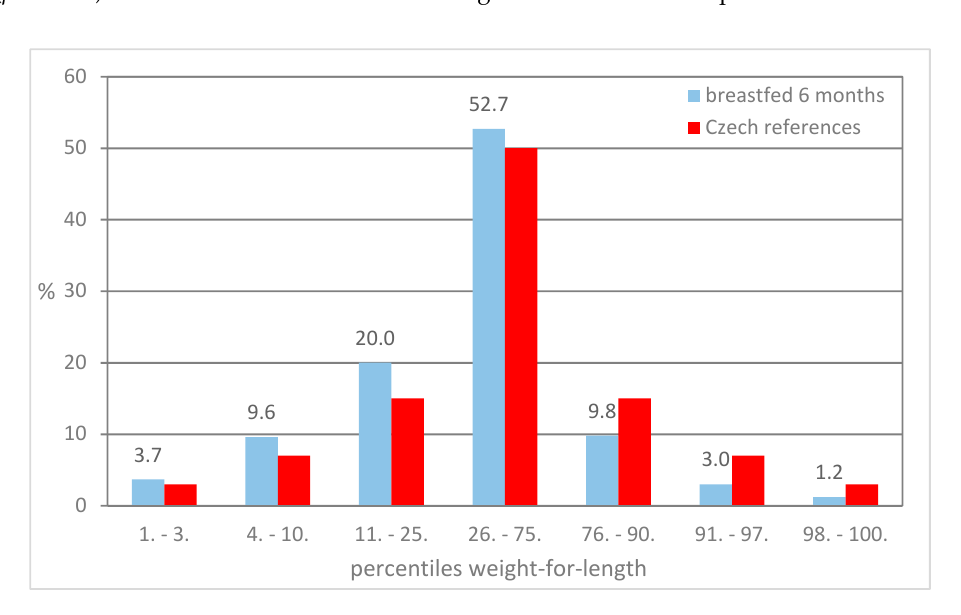
Figure 1. Proportion of children in the percentile categories of weight-for-length at 6 months.